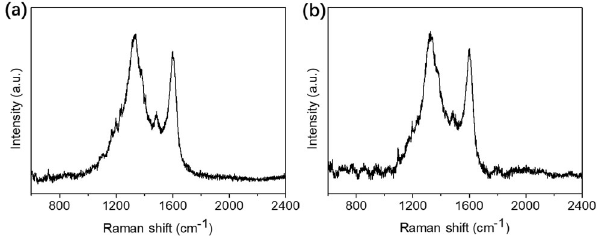
Fig. 10 Raman spectra of the wear scars of the balls sliding against steel disk (a) and copper disk (b) with the TRGO lubricant after friction tests in 3 N from Figs. 8 and 9.